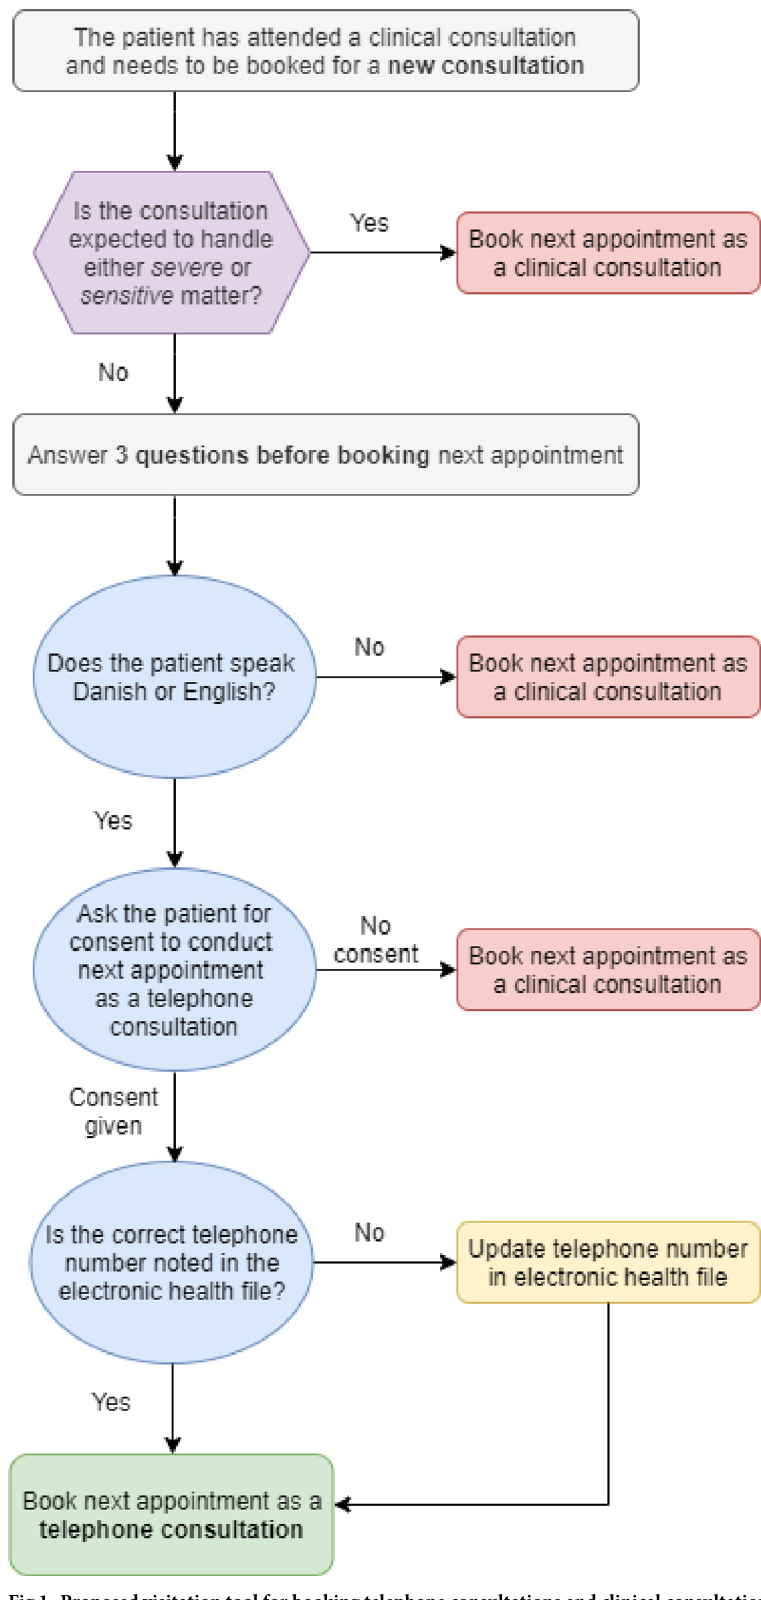
Fig 1. Proposed visitation tool for booking telephone consultations and clinical consultations with patients.